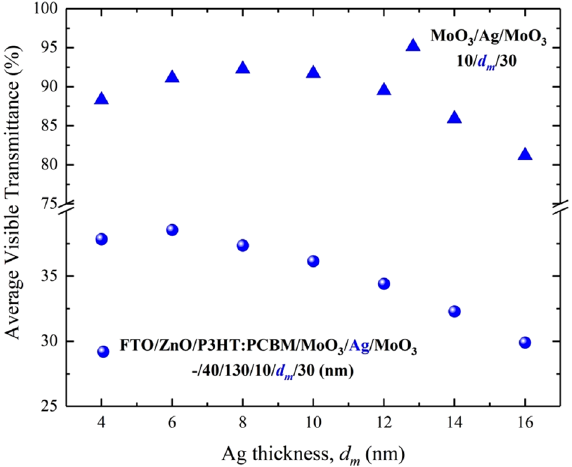
S AM 1.5 G ( (cid:31) ) changes. The × S AM 1.5 G ( (cid:31) ) and the area is the value of the integral in the ×